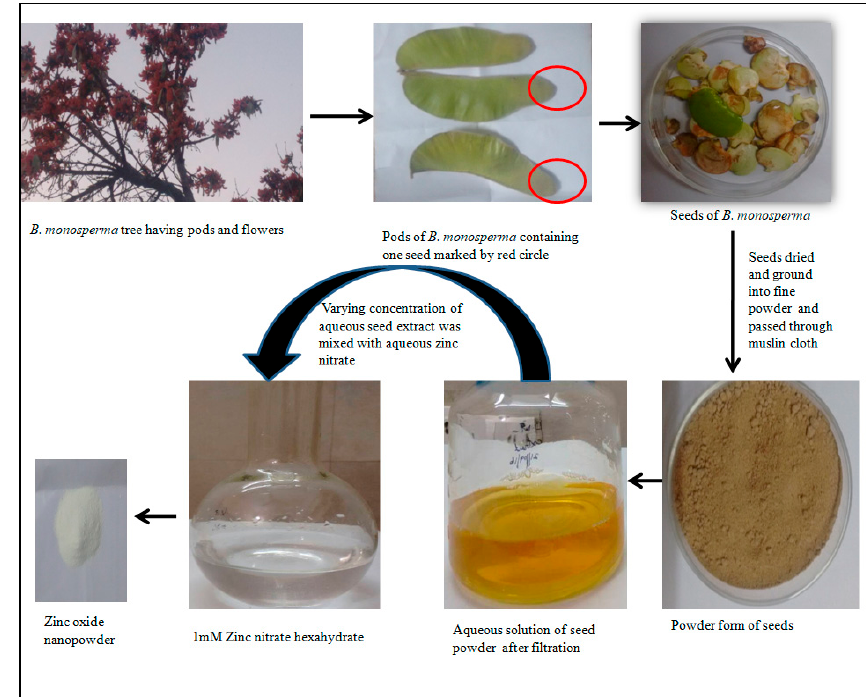
Figure 1. Diagrammatic representation of overall process of formation of ZnO NPs using Butea monosperma seeds.